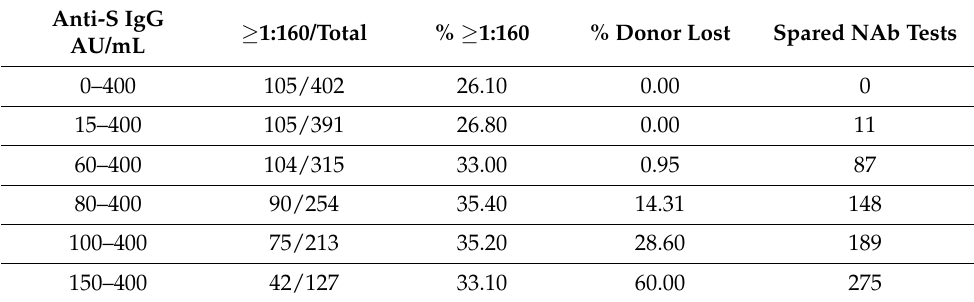
Table 1. Set up of Convalescent Plasma Testing Algorithm.